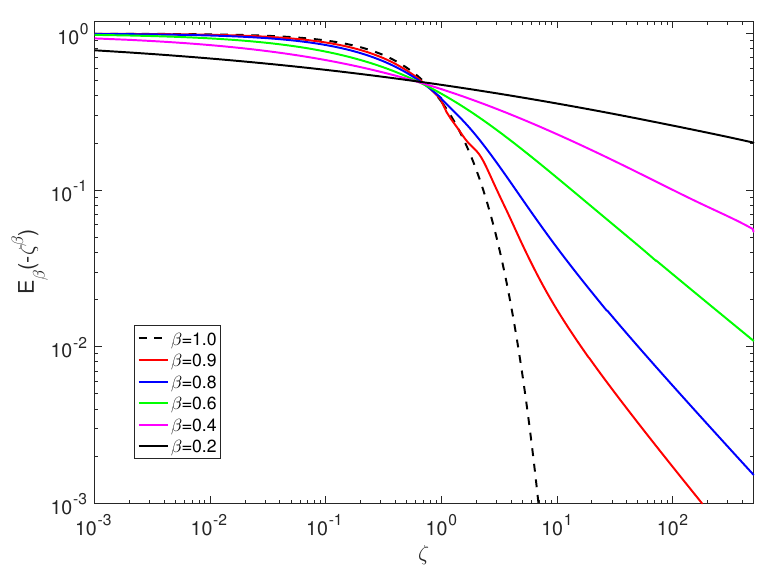
Figure 3. Plots of Mittag-Leffler function E β ( − ζ β ) for various β values. Log–log